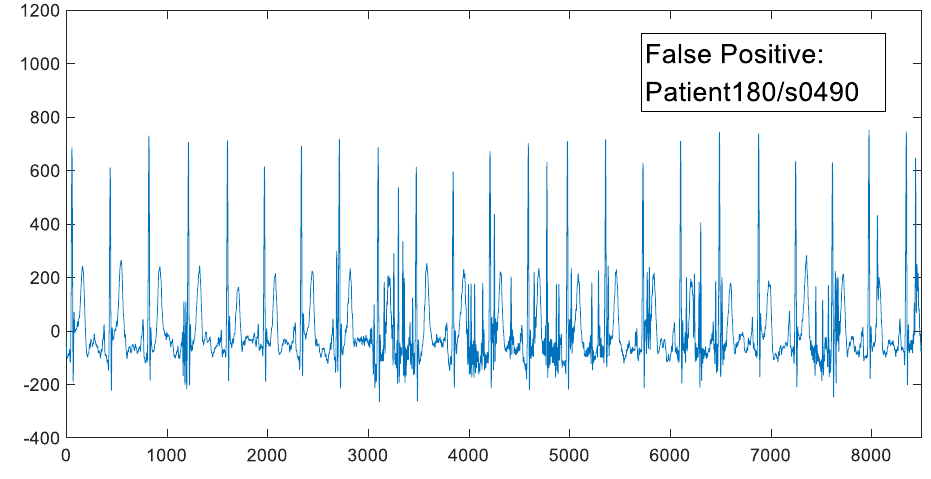
Figure 9. The ECG waveform of a false positive sample.